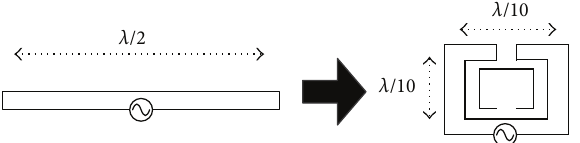
Figure 1: Size comparison of folded-dipole loop with SRR loading.